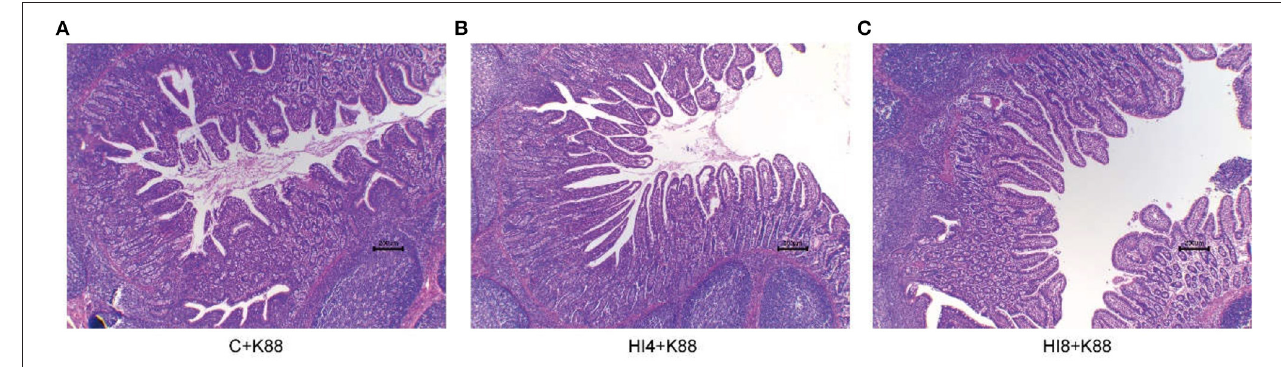
FIGURE 3 | Representative ileum morphology of different group piglets. (A) Morphology of ileum villi in C + K88 group. (B) Morphology of ileum villi in C + K88 group. (C) Morphology of ileum villi in C + K88 group. Representative optical micrographs of intestinal cross-sections. Scale bar = 200 µ m. n = 3.